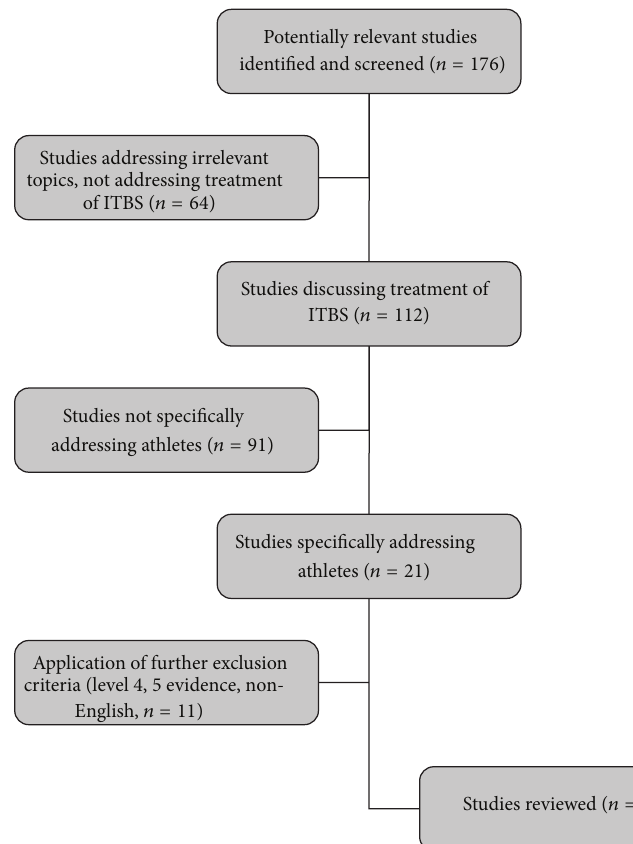
Figure 1: Flow chart displaying search process for